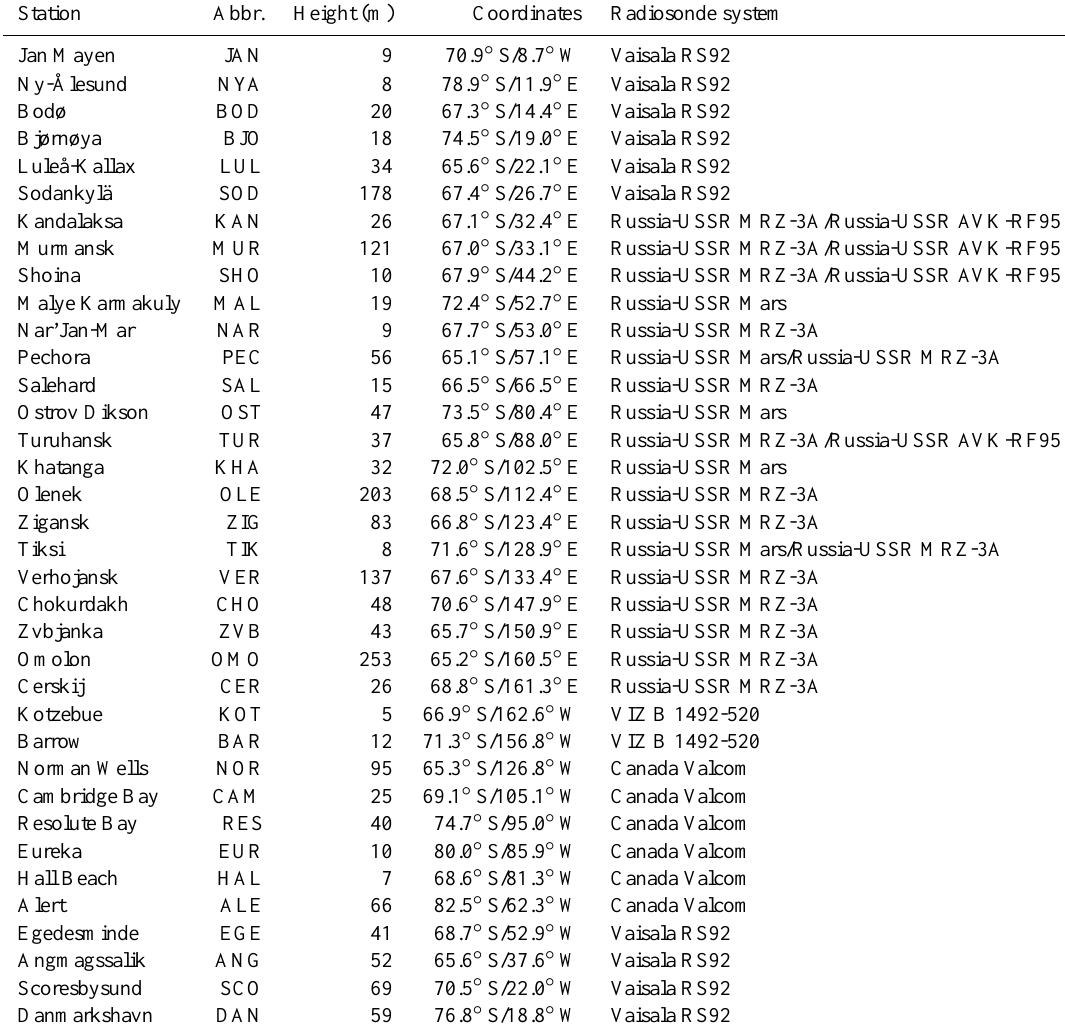
Table 1. Radio-sounding stations included in the study: station names with their abbreviations, station heights above the sea level, coordinates, and radiosonde types ∗ used in